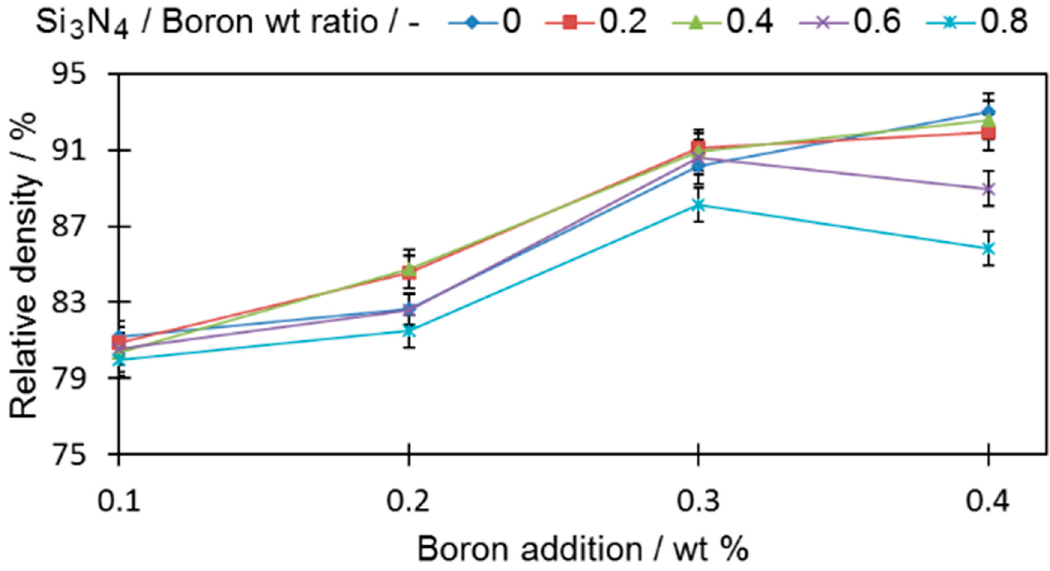
Figure 3. The influence of boron and silicon nitride on the relative density of cylindrical samples. Numerical data are available in Table S2 in Supplementary Material.